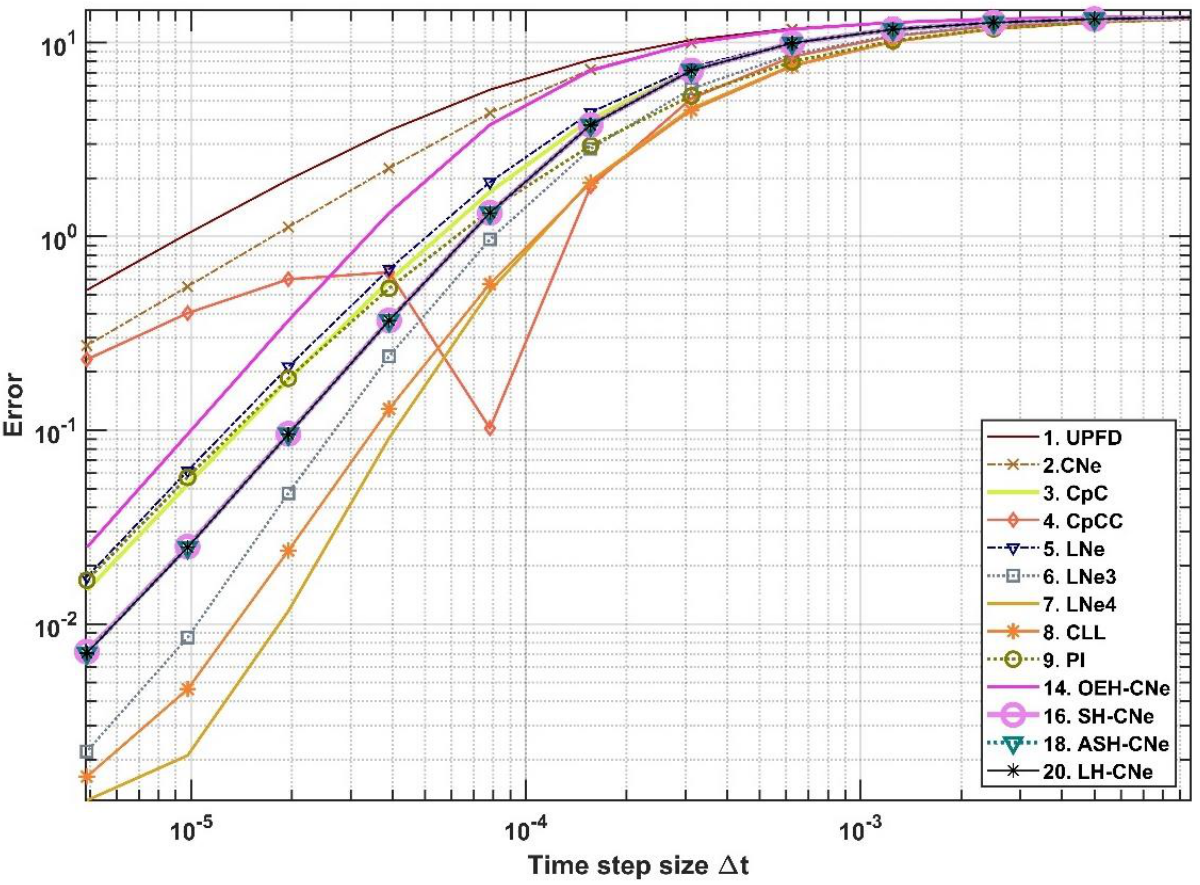
Figure 15. The maximum errors as a function of the time step size ∆ t for the slowly converging methods in the case of Experiment 6, where the diffusion constant strongly depends on the time.